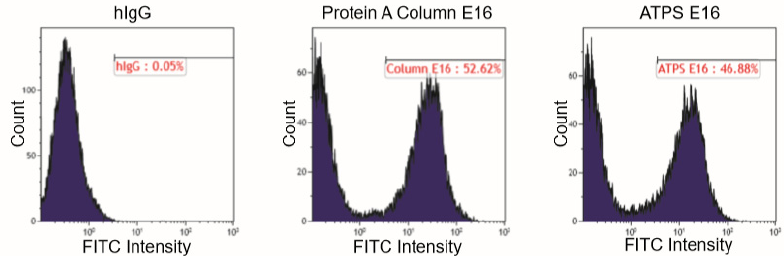
Figure 4. Binding of ATPS-enriched E16 to domain III of WNV E displayed on the surface of yeast cell. Yeast cells displaying domain III of WNV E protein were incubated with ATPS-enriched E16, Protein A column-purified E16 (positive control), or a generic human IgG (hIgG, negative control), and then stained with a Fluorescein isothiocyanate (FITC)-conjugated antibody. Yeast cells were then processed by flow cytometry to monitor the specific binding of E16 to WNV E domain III (DIII).